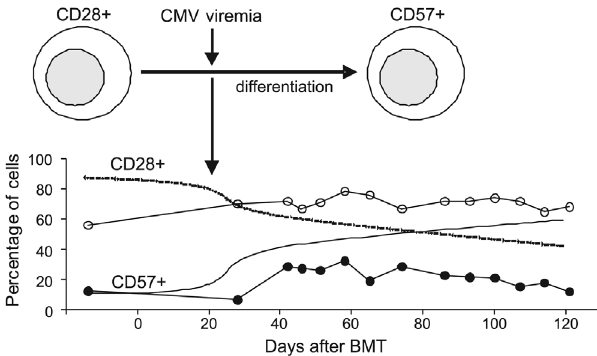
Figure 4 - Proposed model for CD8+ T lymphocyte subset reconstitution after BMT and the effect of CMV viremia. A continuous relative decrease in CD28+ cells, along with a continuous relative increase in CD57+, takes place after BMT engraftment. The occurrence of CMV viremia exerts a substantial effect on this system, causing a steep incline in both